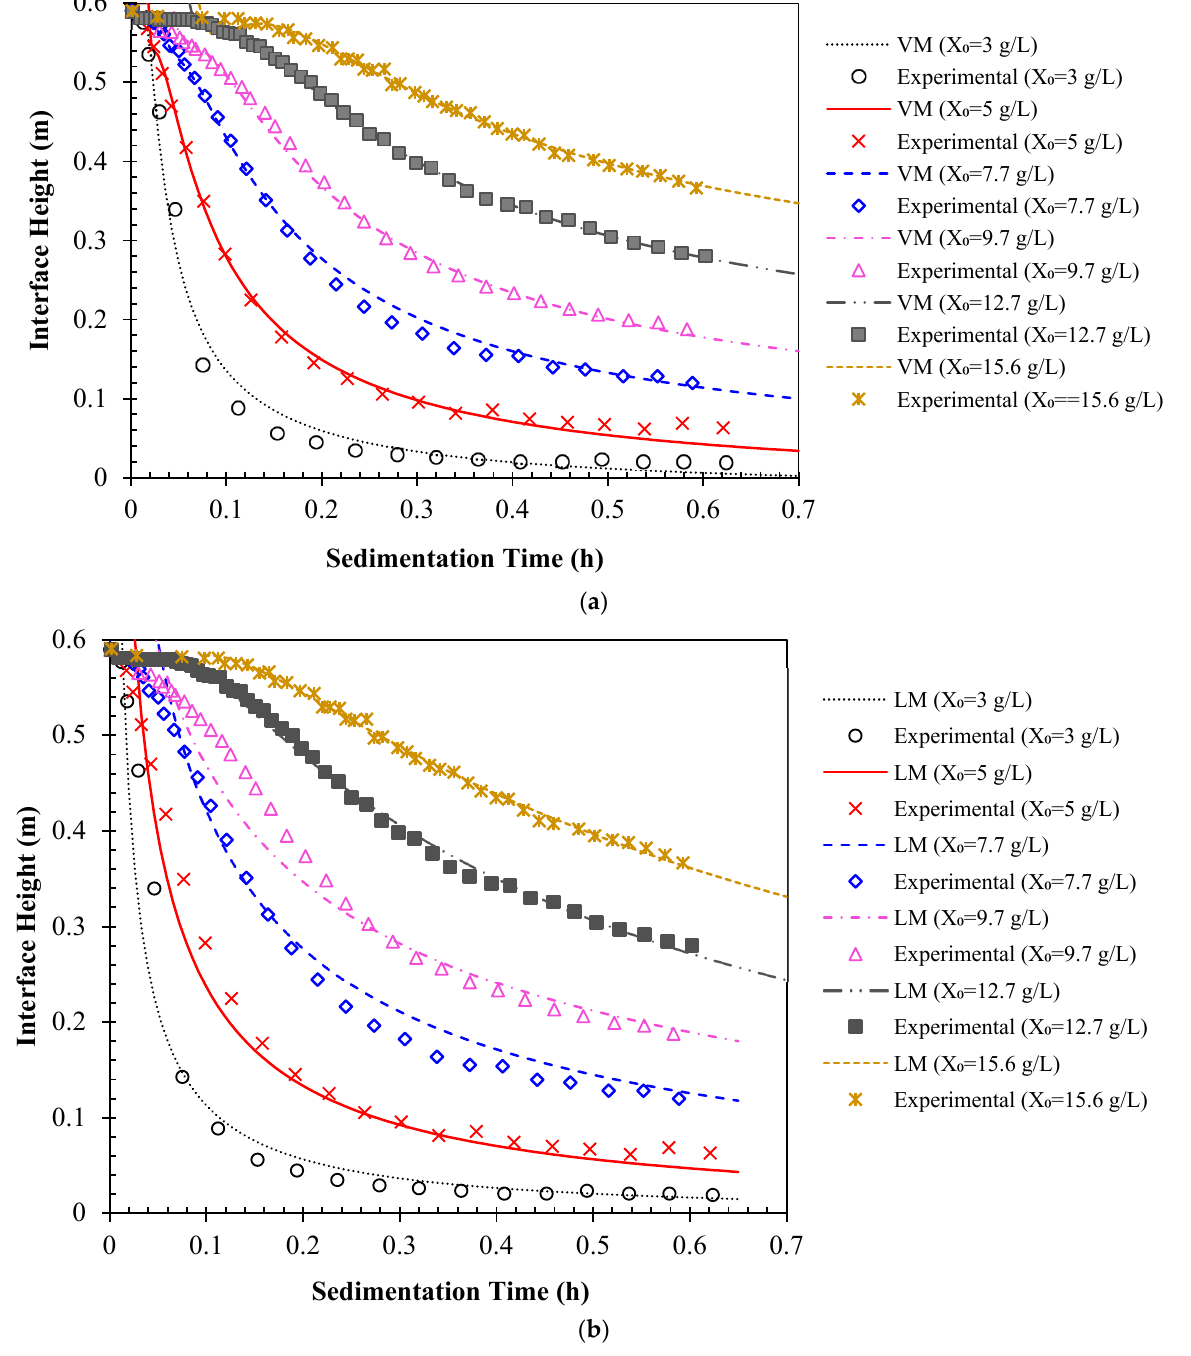
Figure 4. Comparison between the measured solid settling data (borrowed from [21]) and the data predicted using ( a ) the VM-based model using Equations (6)–(10) and ( b ) LM-based model using Equation (11).